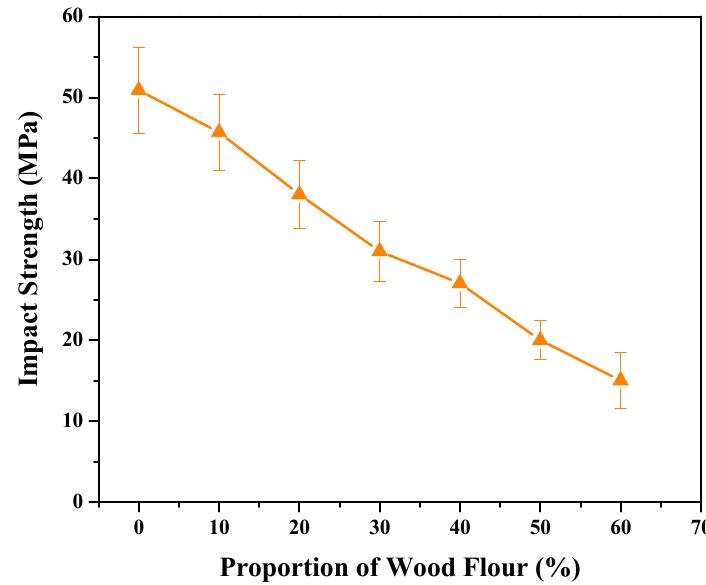
Figure 7. Impact strength via different wood flour proportions.